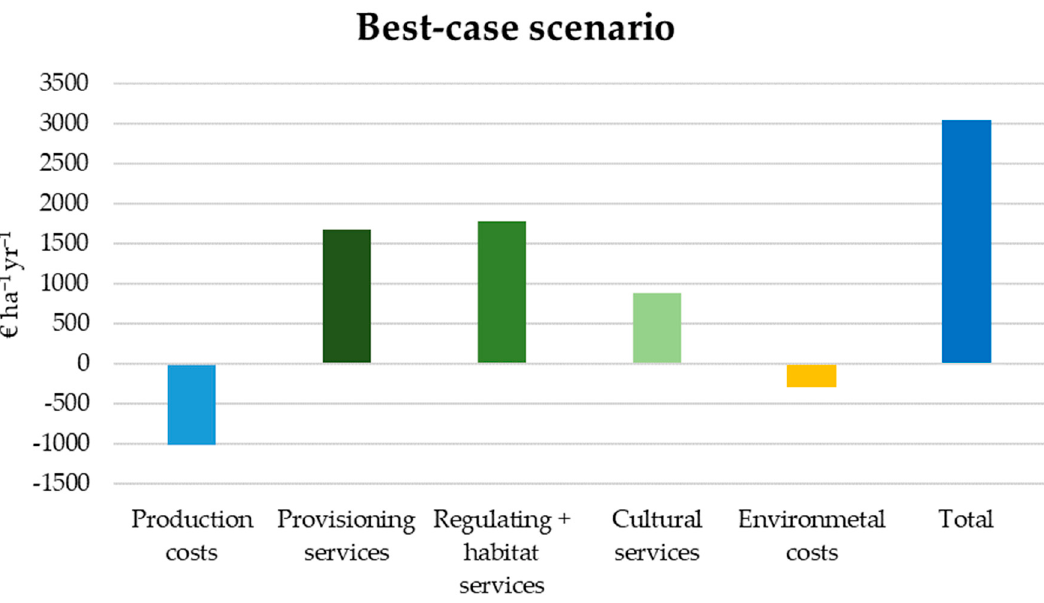
Figure 3. True costs and benefits in the best-case scenario assuming maximum ESs provision and low monetization factors for environmental impacts. monetization factors for environmental impacts.